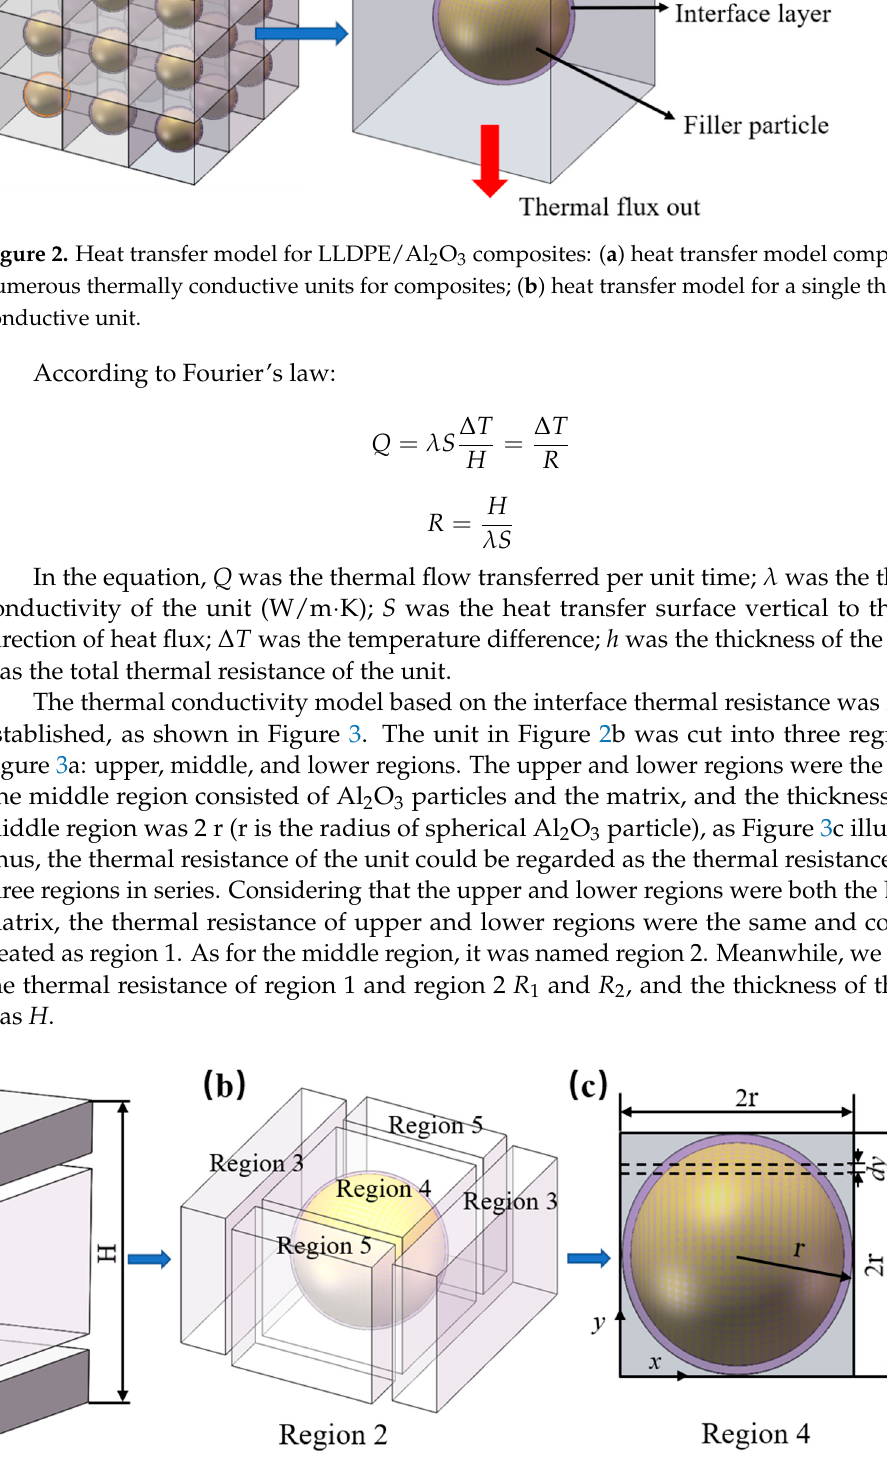
Figure 3. The division strategy for the unit: ( a ) the whole unit; ( b ) region 2; ( c ) a cross-sectional view of region